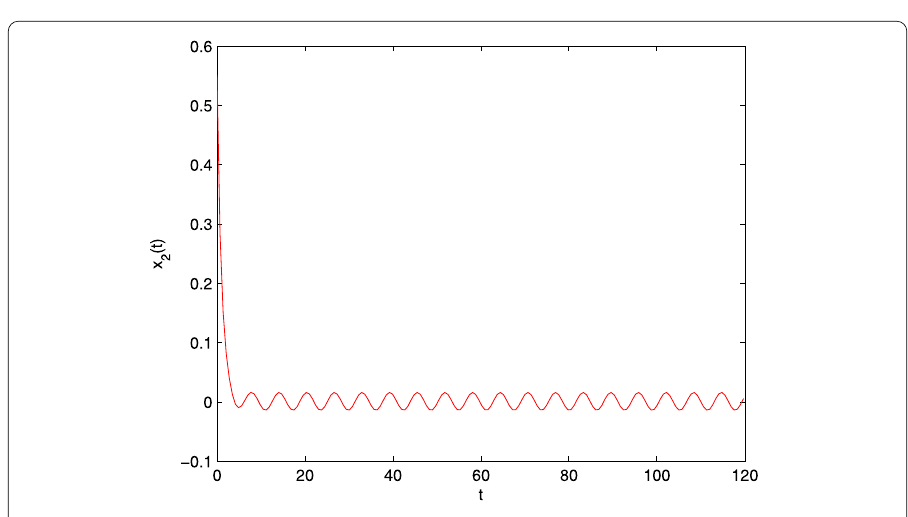
Figure 4 State trajectories of system (4.2) for x 2 ( t